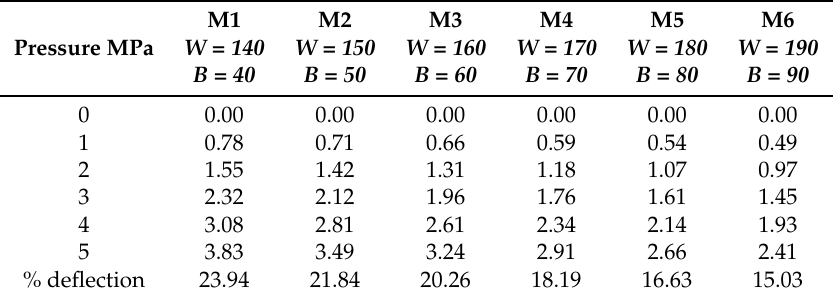
Table 4. Pressure versus center deflection for diaphragms with W and B .